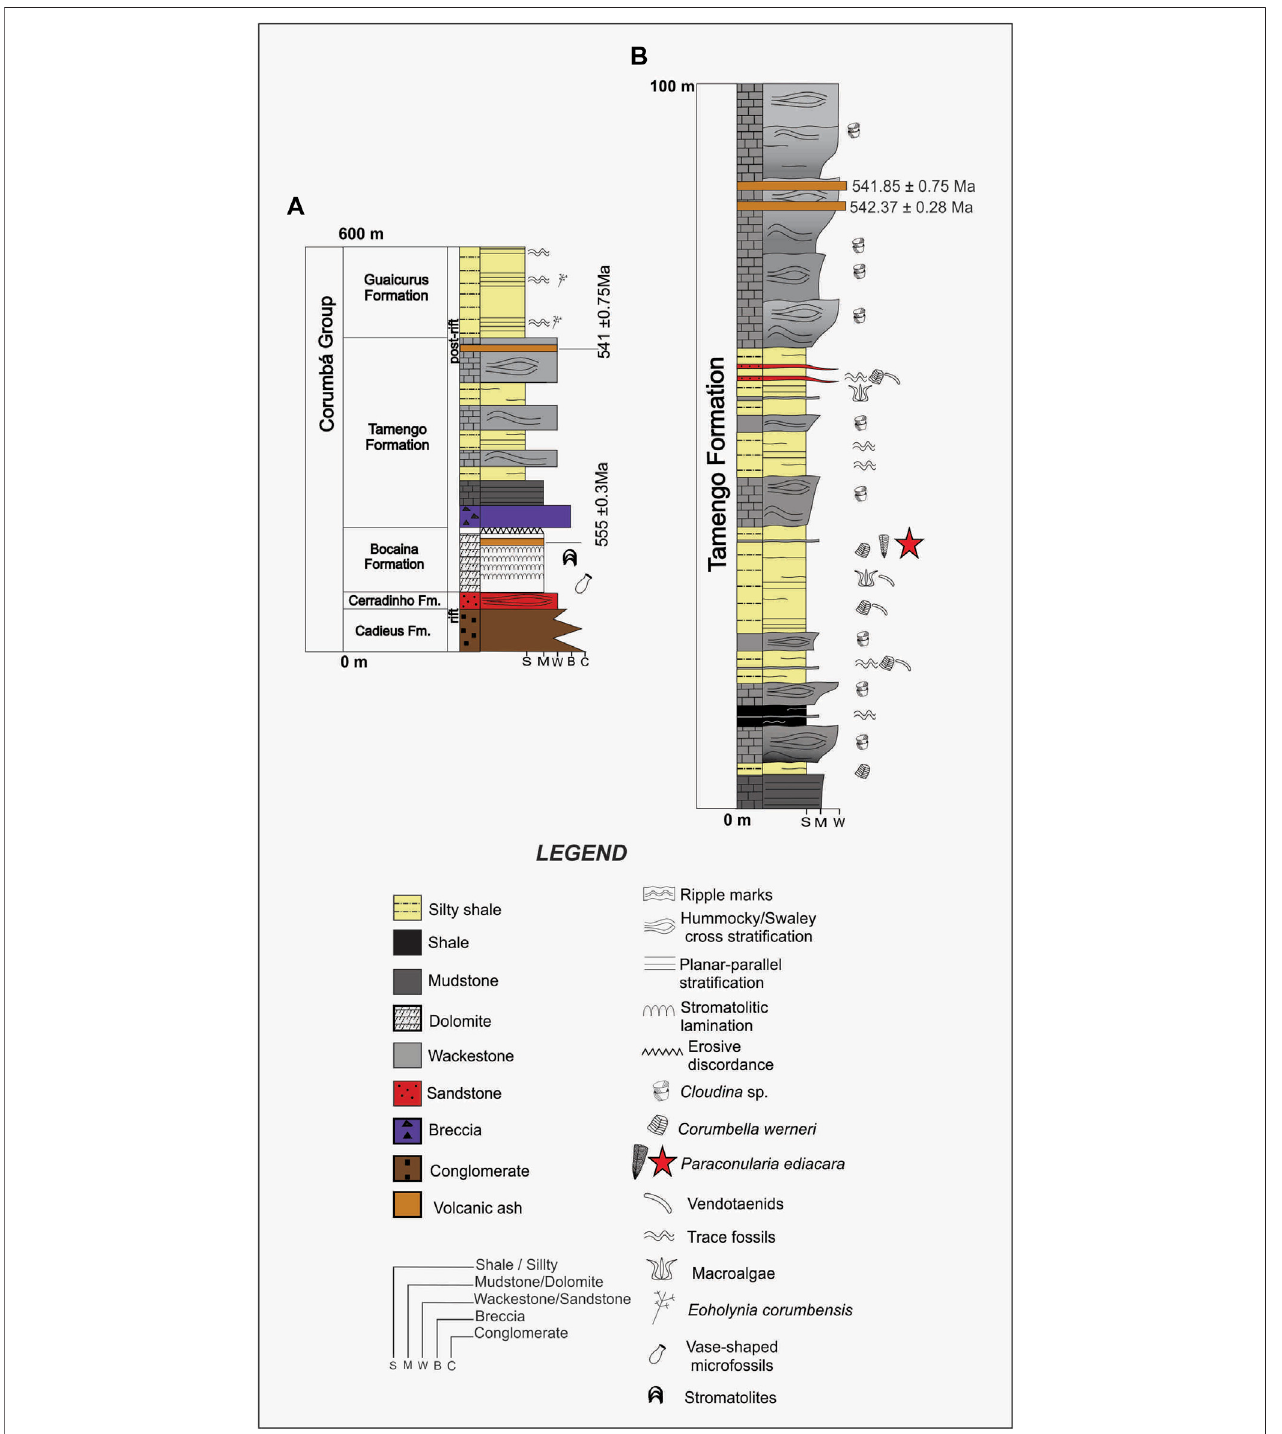
FIGURE 2 | Measured stratigraphic columns for (A) the Corumbá Group and (B) the Tamengo Formation, showing in (B) the levels of occurrence of Cloudina , Corumbella , vendotaenids, macroalgae, and Paraconularia ediacara n. sp. (red star). Modi fi ed from Amorim et al. (2020).